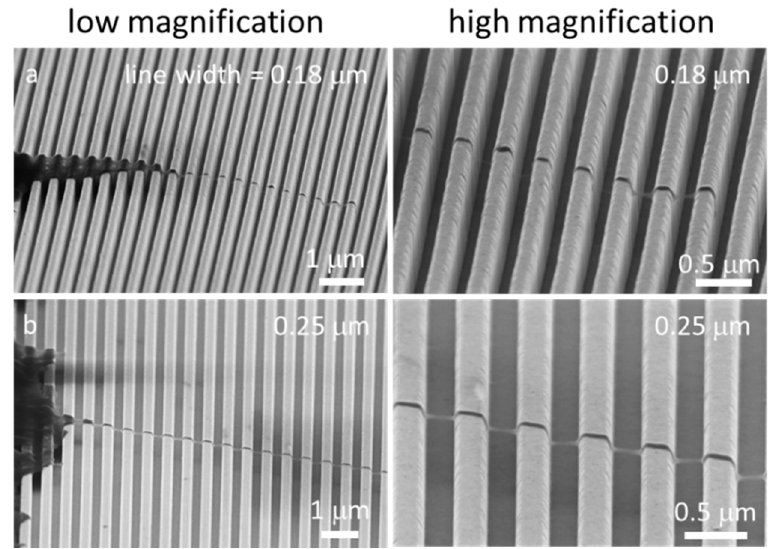
Figure 10. Typical SEM micrographs of adherent cell pseudopodia on ( a ) 0.18 μ m and ( b ) 0.25 μ m comb structures under low and high magnifications. Type 1 characteristics were observed in all filaments where they wrapped around the top portions of the